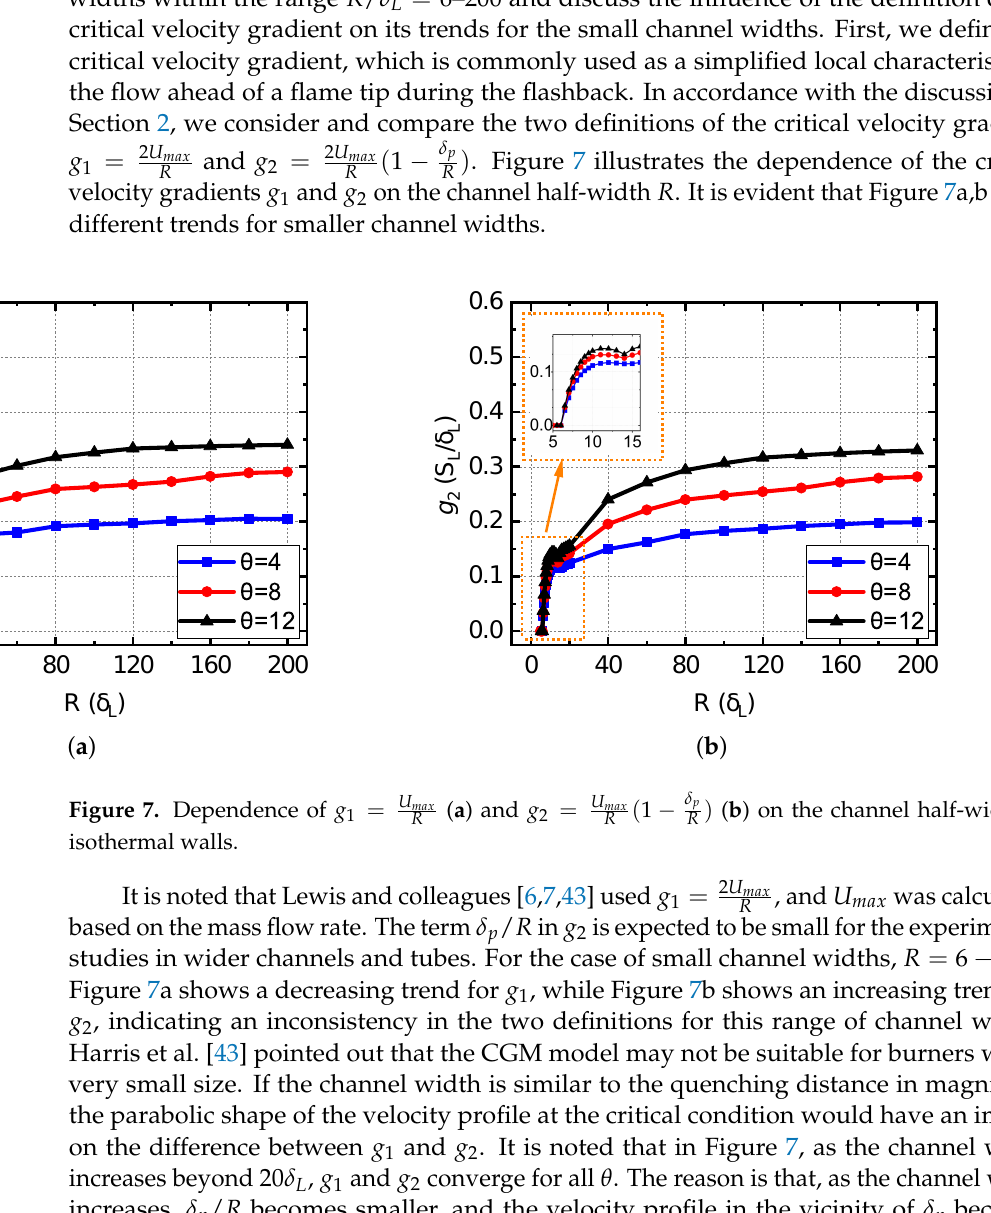
( a ) and g 2 = U max R